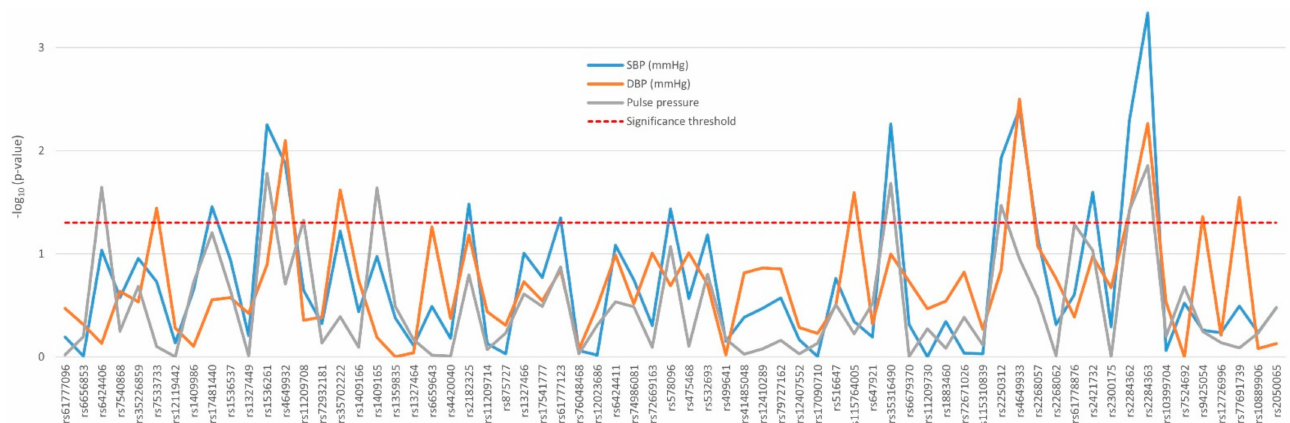
Figure 2. Effect of genetic variability in the PTGER3 gene determined by tag-SNPs on blood pressure traits of nephrosclero- sis